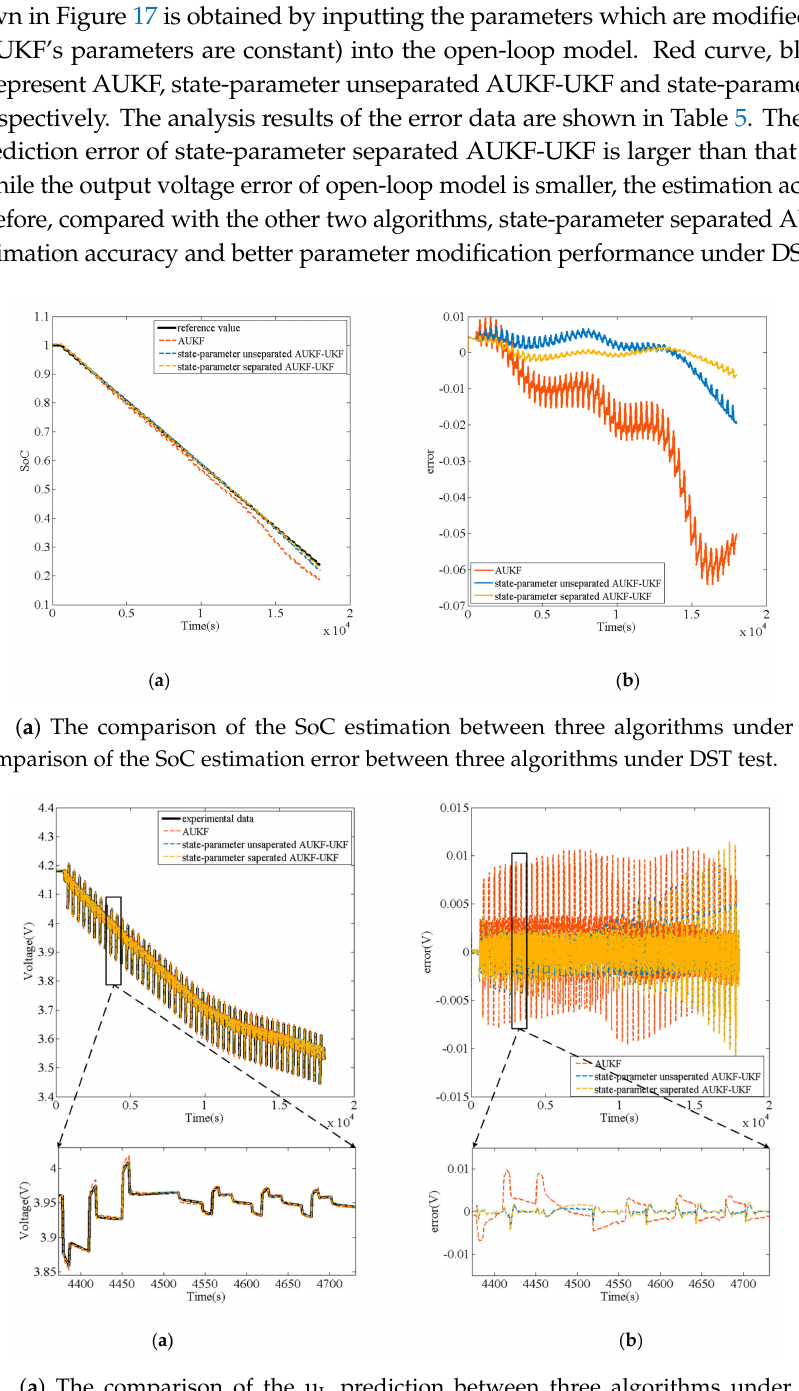
Figure 16. ( a ) The comparison of the u L prediction between three algorithms under DST test; ( b ) The comparison of the u L prediction error between three algorithms under DST